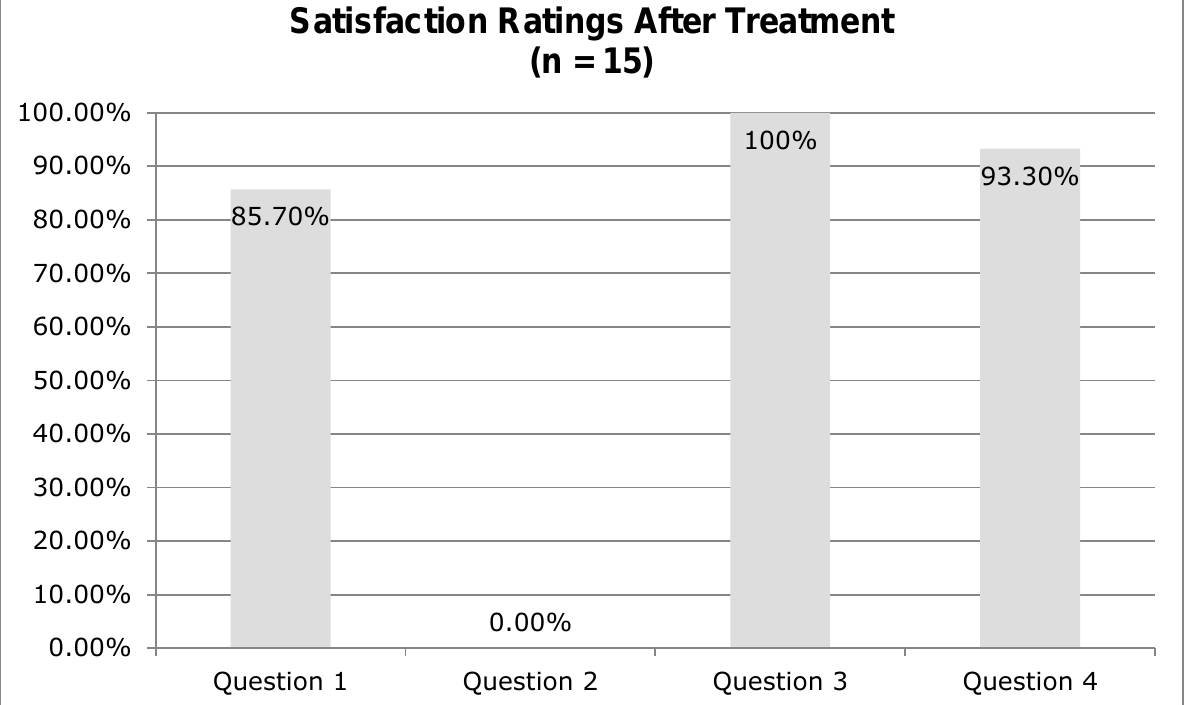
Figure 2. Percentages for each of the four statements after active treatment condition.